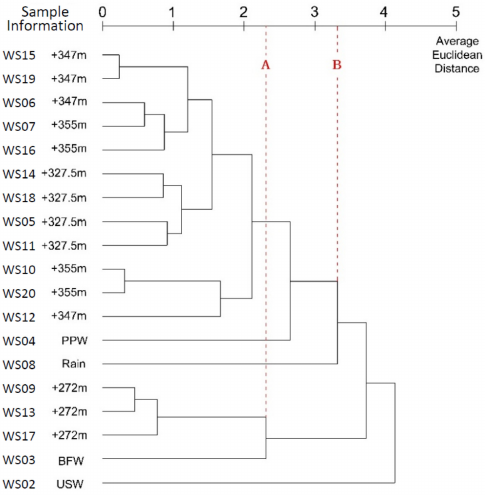
Figure 12. Dendrogram of data through the within-groups